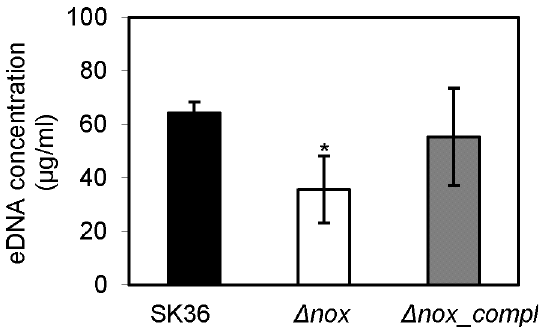
Fig 5. Change in eDNA concentration in the nox mutant. Δ nox , the nox mutant; Δ nox_compl , the complemented strain of the nox mutant. * , significant difference with P < 0.05 compared to SK36. Data obtained at least in